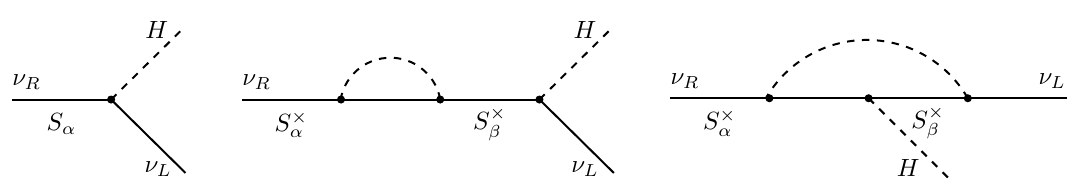
Figure 12 . Diagrams for the decay (cid:23) (cid:11) factor " (cid:11) . At O ( (cid:21) 4 ) the relevant contribution to the (cid:0)( (cid:23) R ! (cid:23) L H ) decay rate arises from the interference of the tree and one-loop diagrams shown. (Two further loop diagrams, with a self- energy insertion on the incoming (cid:23) R line or on the outgoing (cid:23) L line, do not contribute to the asymmetry.) Similar diagrams, where the S (cid:11) and S (cid:2) to the (cid:12)gure, give the decay rate for (cid:23) (cid:11) shows that the asymmetry depends on the combination P f ( M (cid:11) ; M (cid:12) ) is a kinematical factor from evaluating the diagrams.